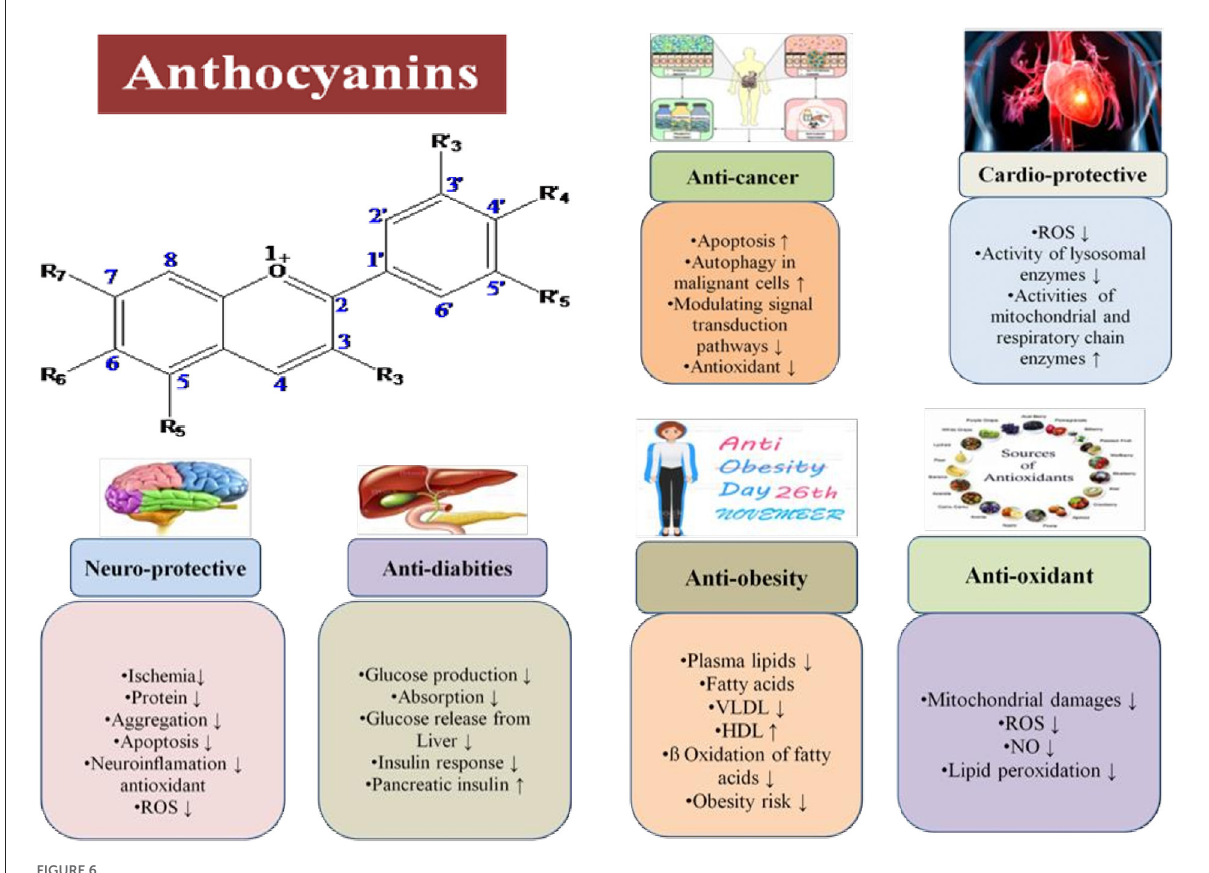
FIGURE6 Physiological and health implications of